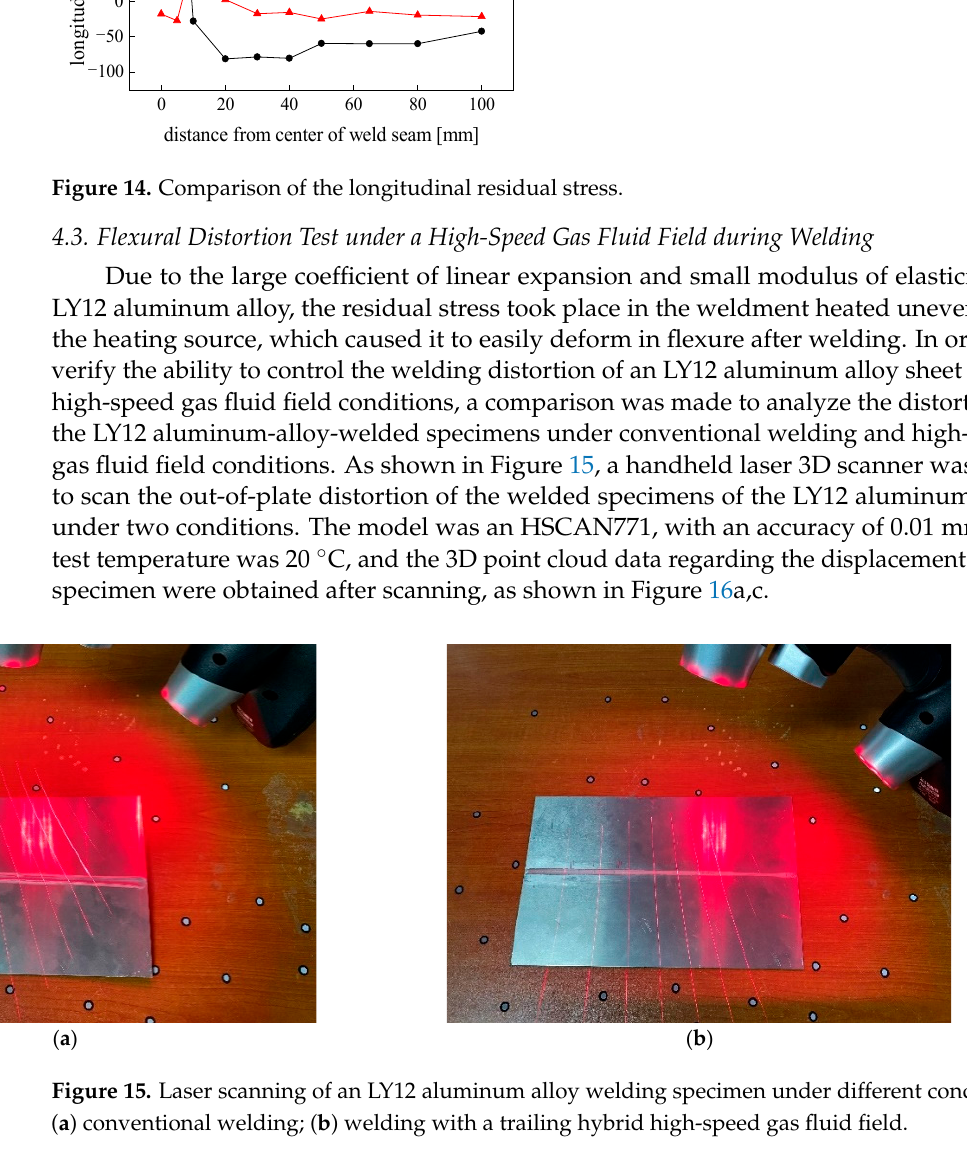
Figure 14. Comparison of the longitudinal residual stress.